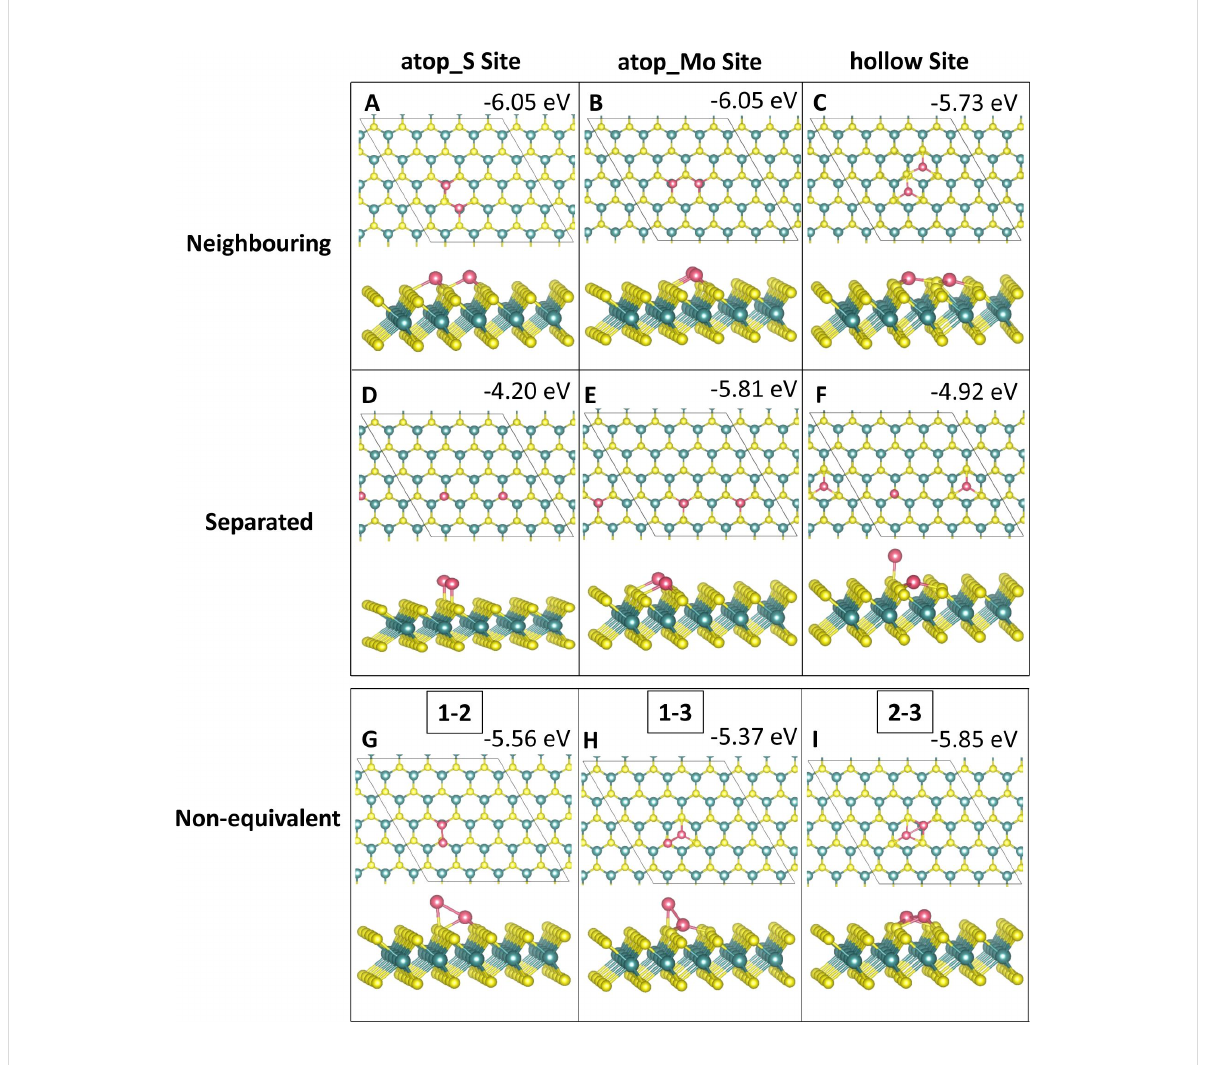
Figure 3: Atomic structure and energies of Co 2 adsorption modes on perfect MoS 2